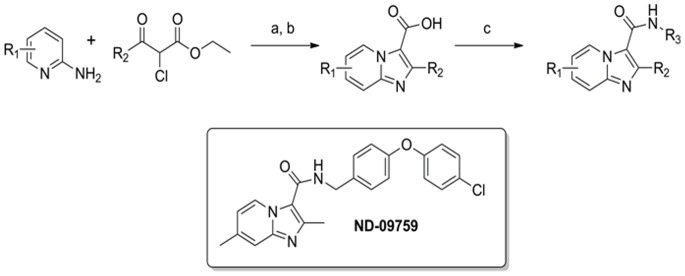
General three step synthesis of IPAs and the chemical structure of ND-09759, N-(4-(4-chlorophenoxy)benzyl)-2,7-dimethylimidazo[1,2-a]pyridine-3-carboxamide.Reagents: (a) 1,2-Dimethoxyethane, reflux, 48 h.; (b) 1. LiOH, Ethanol, 2. HCl, 56 h.; (c) EDCI, DMAP, (4-(4-chlorophenoxy)phenyl)methanamine, CH3CN, 16 h.